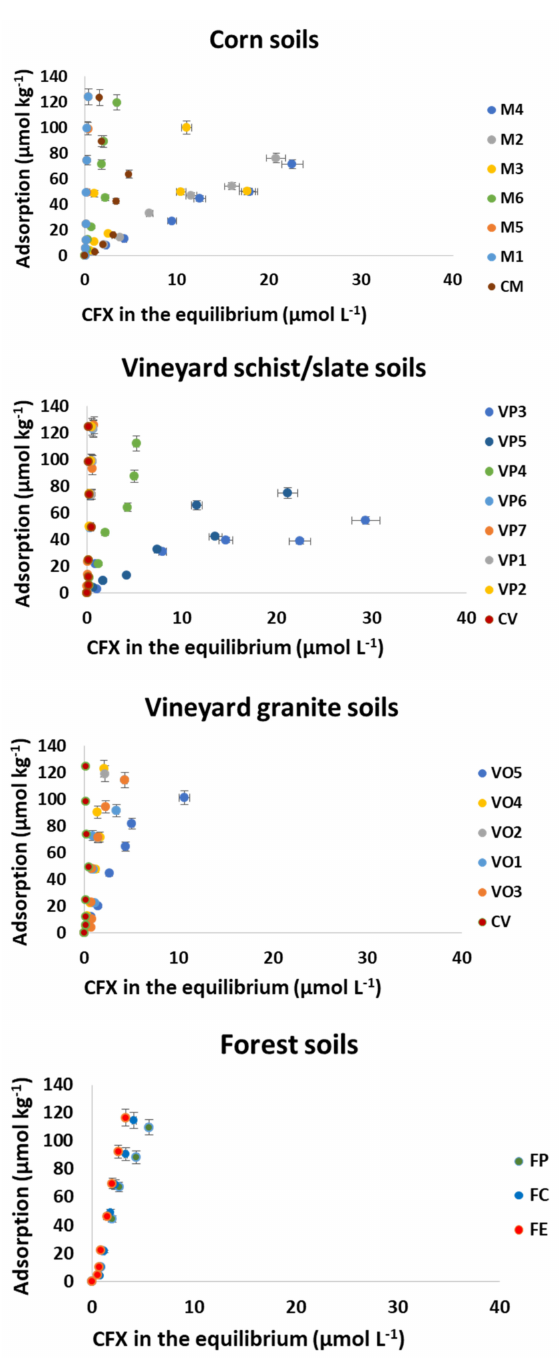
Figure 2. Adsorption curves for CFX on the various soils were studied. M, maize (corn) soils; VO, vineyard soils (Ourense province); VP, vineyard soils (Pontevedra province); F, forest soils; CM and CV, control soils in maize and vineyard areas. Average values ( n = 3), with coefficients of variation always